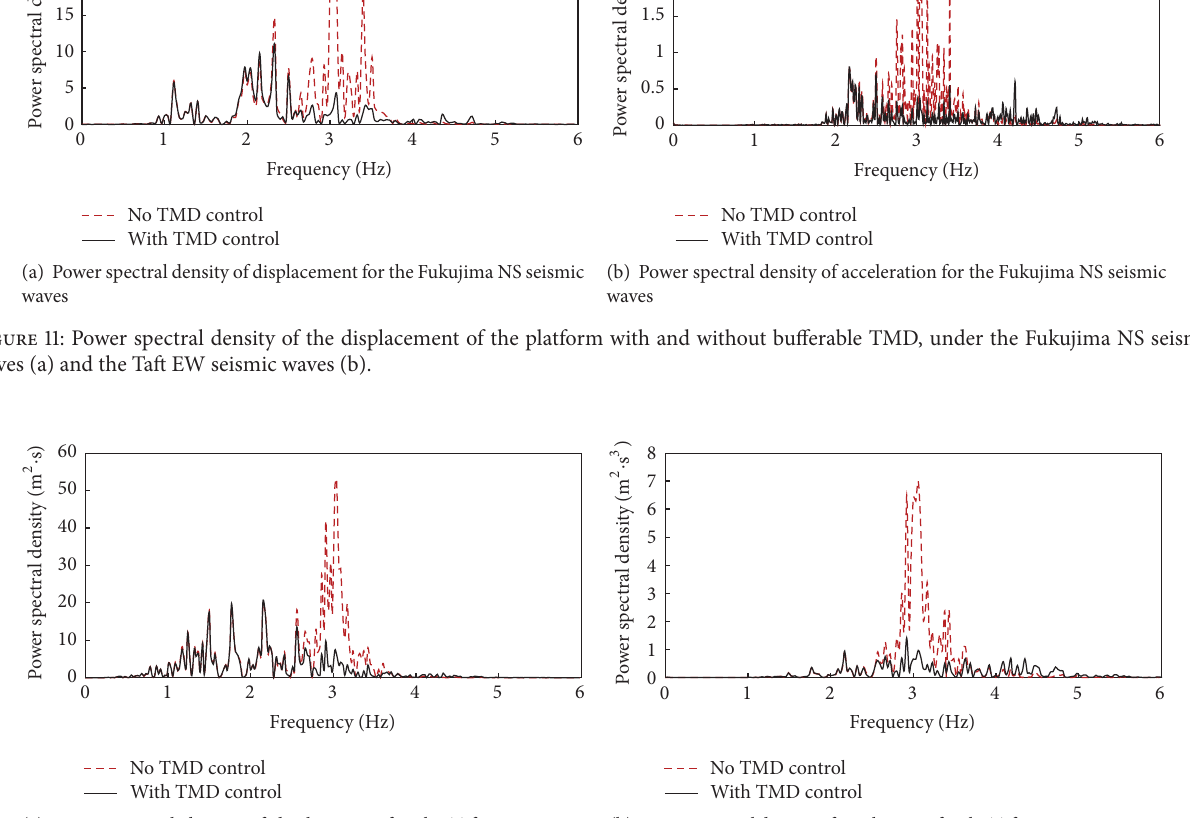
Figure 12: Power spectral density of the accelerations of the platform with and without bufferable TMD, under the Fukujima NS seismic waves (a) and the Taft EW seismic waves